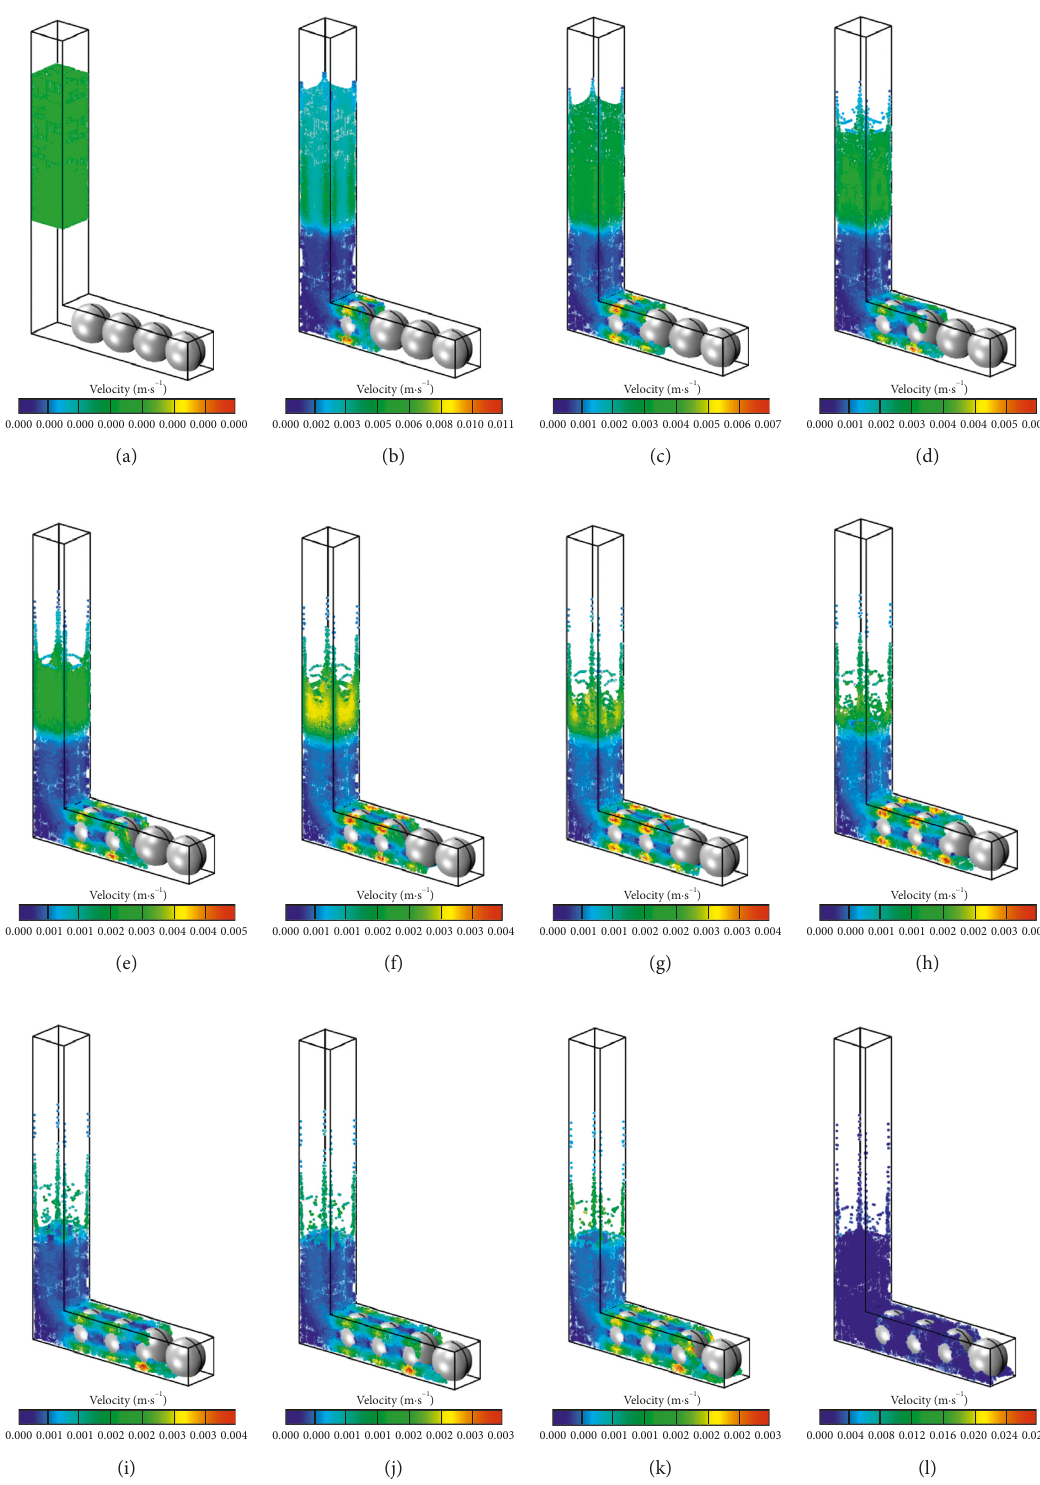
Figure 7: The velocity distribution of the enhanced L-box test. (a) t � 0 s, (b) t � 25s, (c) t � 50s, (d) t � 75s, (e) t � 100s, (f) t � 125s, (g) t � 150s, (h) t � 175s, (i) t � 200s, (j) t � 225s, (k) t � 250s, and (l) final